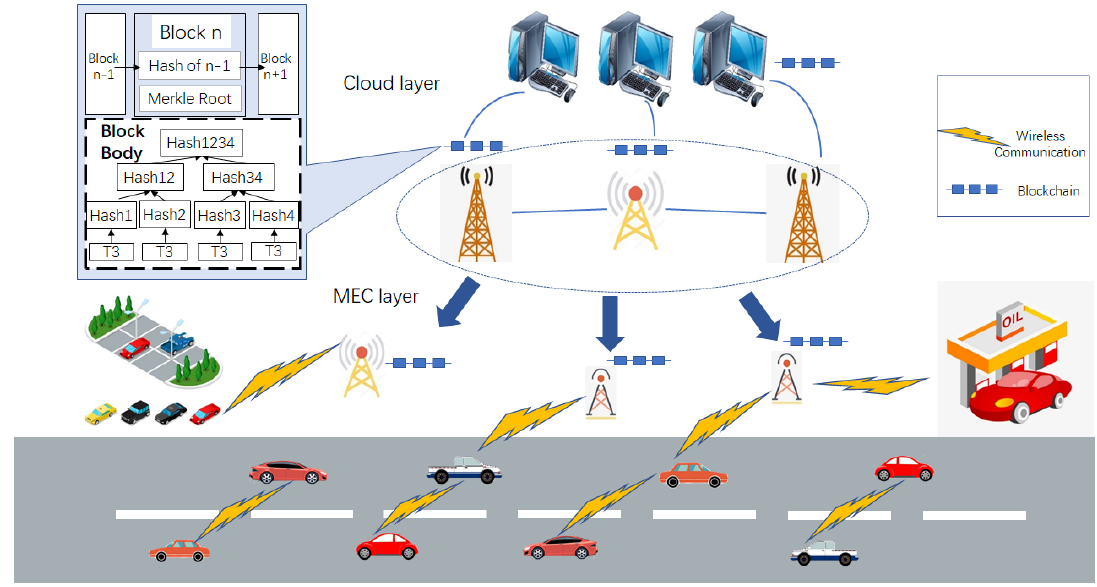
Figure 5. Blockchain in vehicular